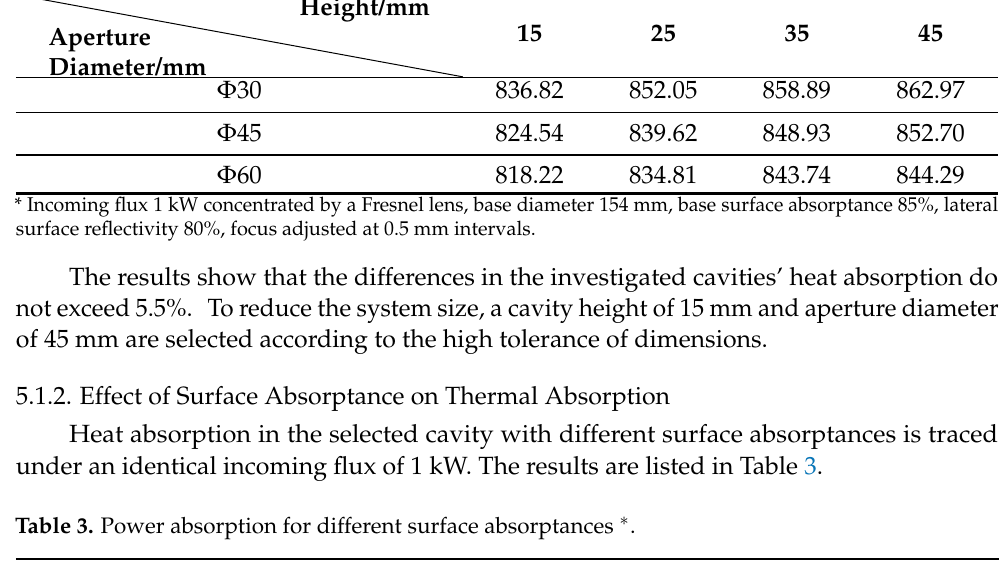
Table 2. Power absorption of different dimensions *. Aperture